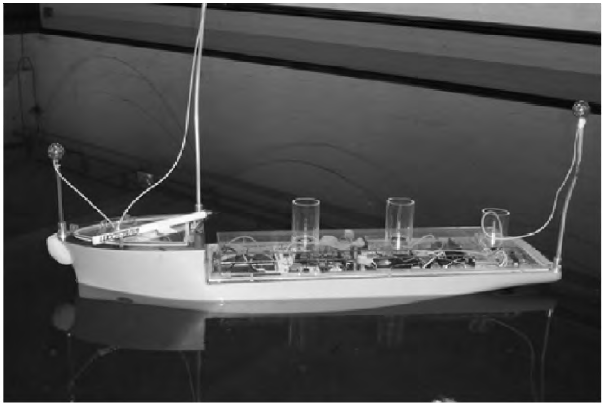
Figure 3. A picture of CyberShip II in the Marine Cybernetics Laboratory at